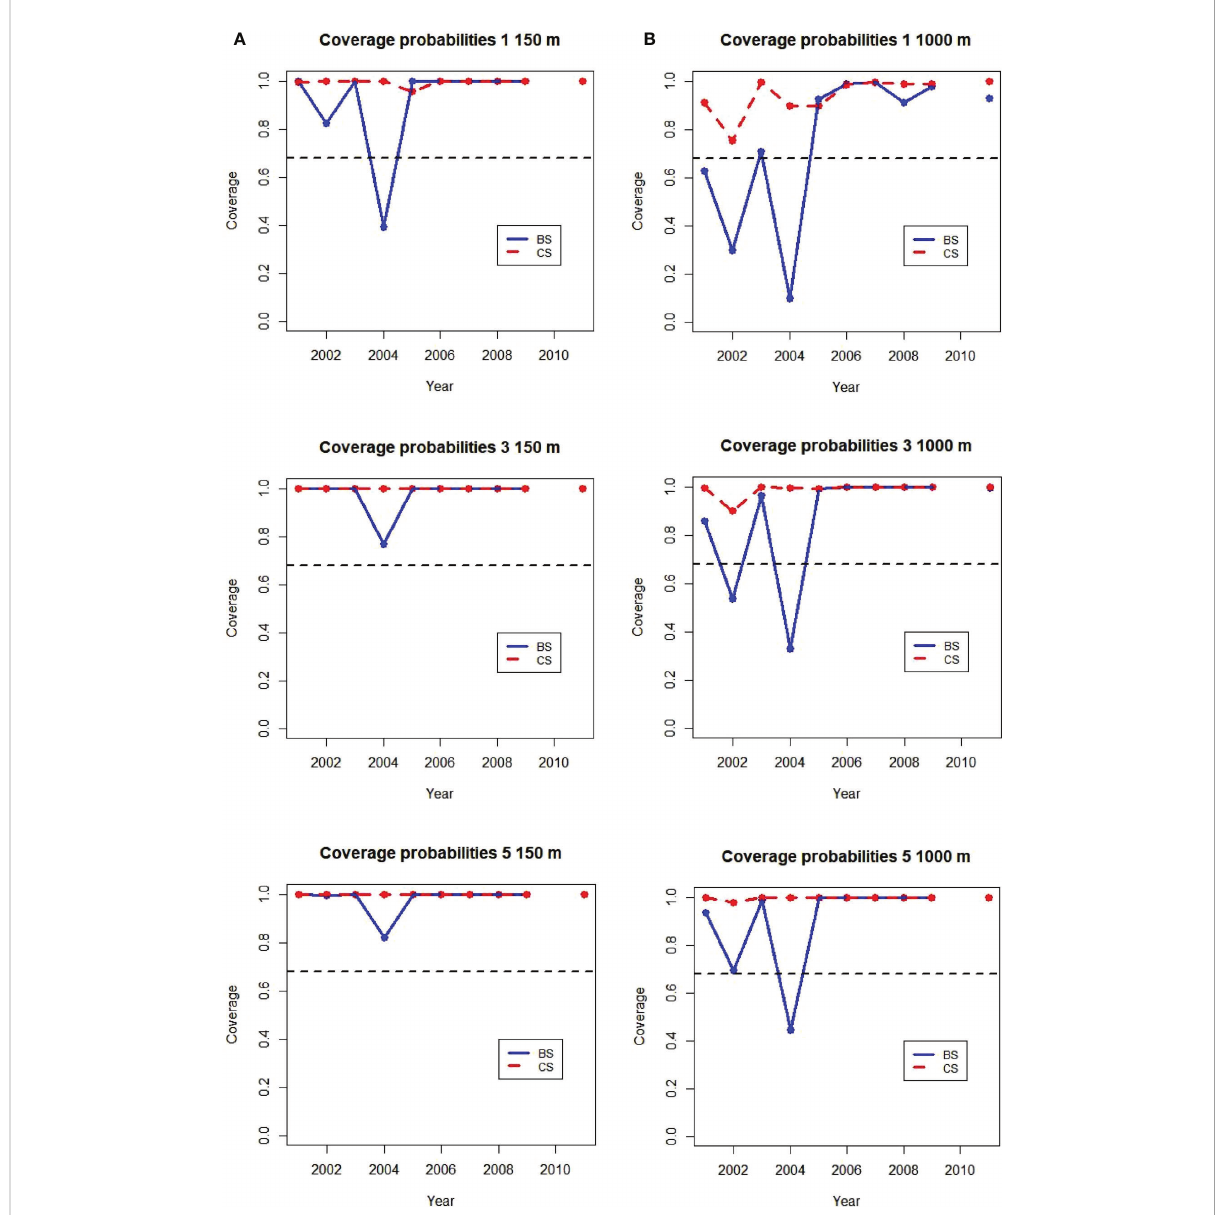
FIGURE 9 Annual coverage probabilities of 1, 3, and 5 gliders sampling at (A) 150 m (0.9 km trackline/dive) and (B) 1000 m (4.5 km/dive) maximum dive depth in the Bransfeld Strait (BS) and Cape Shirref (CS) strata. The expected value of 68% is shown as the dashed black line. No ship samples were available from